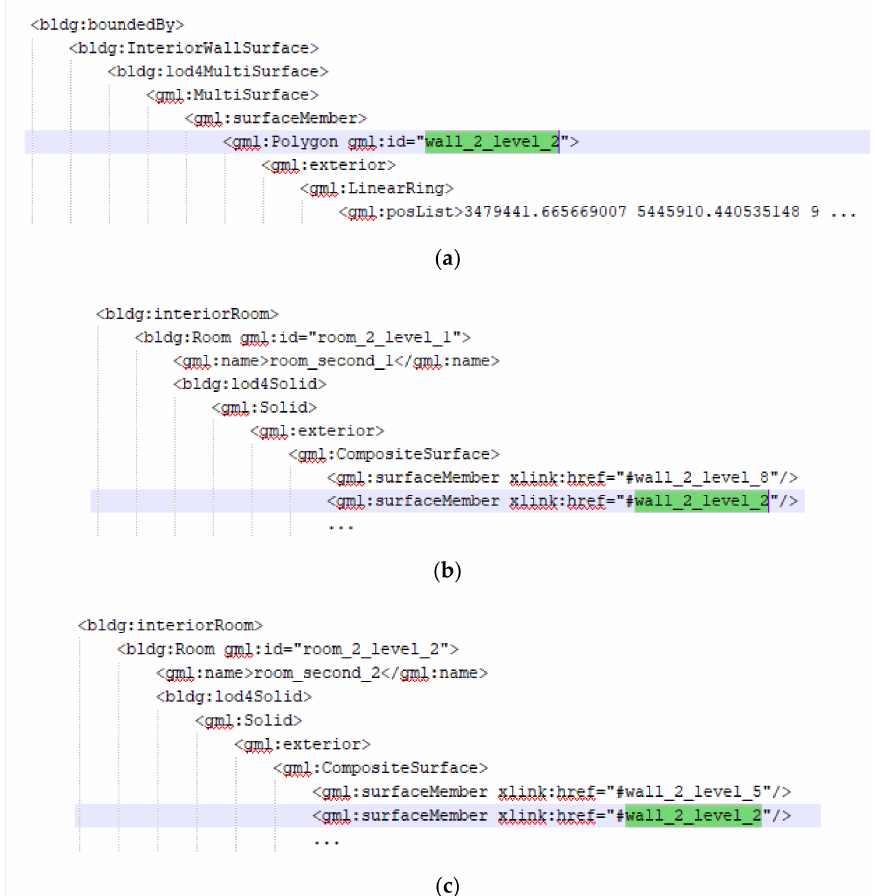
Figure 26. Excerpt from the CityGML dataset of an interior wall shared by two adjacent rooms. ( a ) XML description of an interior wall “wall_2_level_2”. ( b ) The wall “wall_2_level_2” is referenced by a room “room_second_1” through XLinks. ( c ) The wall “wall_2_level_2” is referenced by a room “room_second_2” through